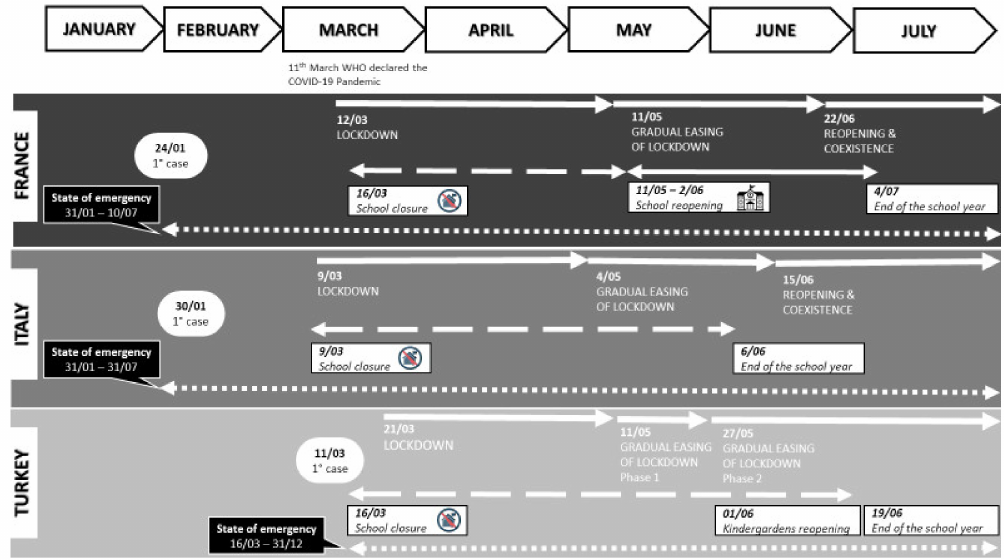
Figure 1. Lockdown phases and school closures in France, Italy, and